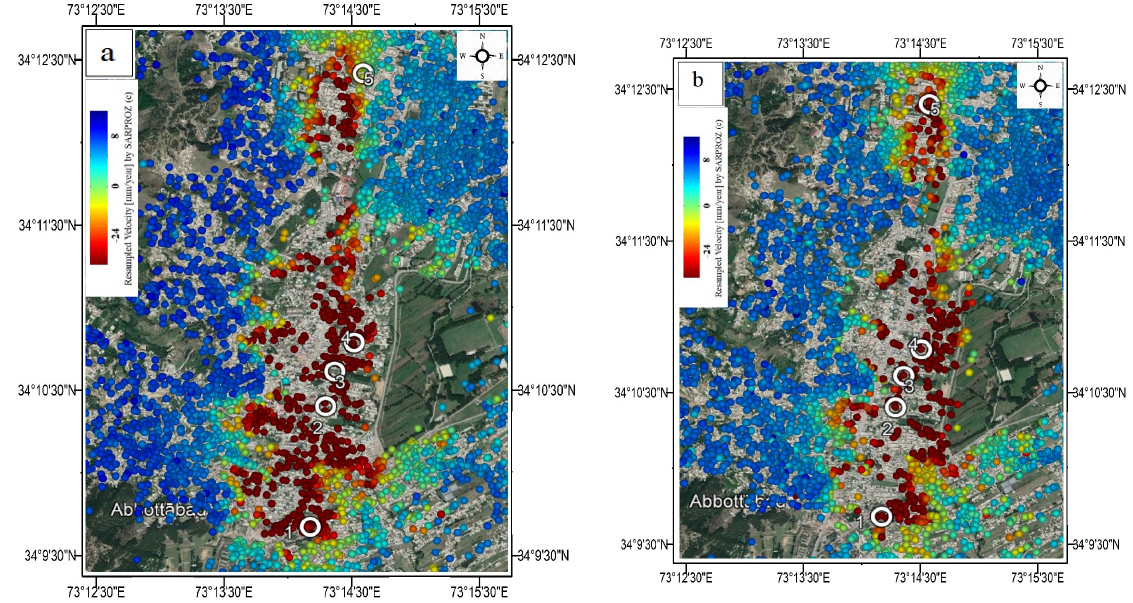
southern parts of the city.